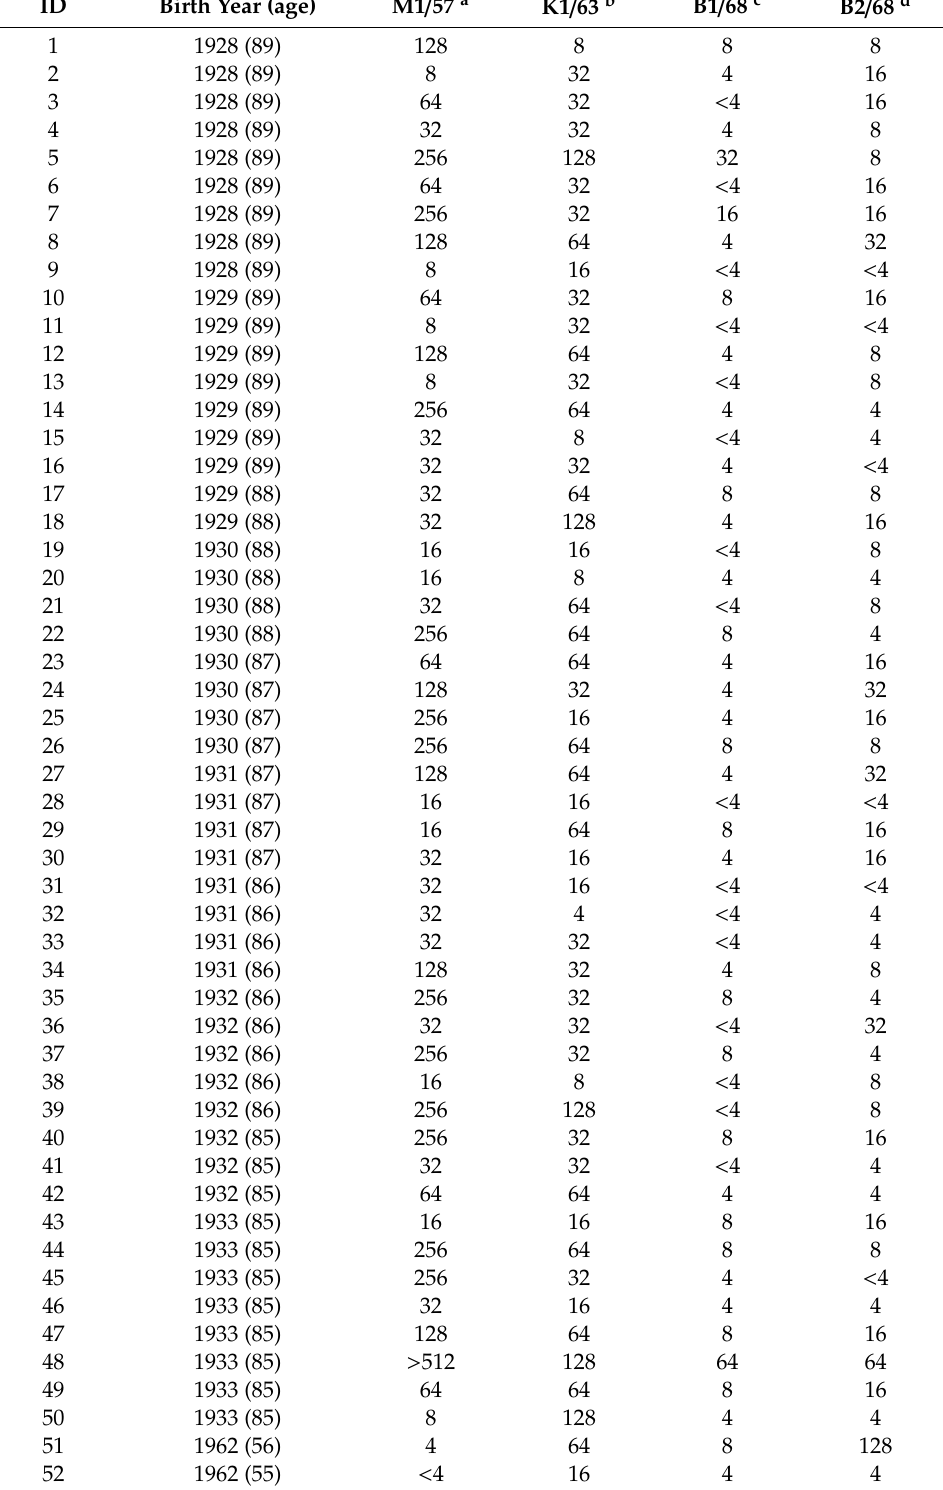
Table 2. Neutralization titers of aged and younger adult